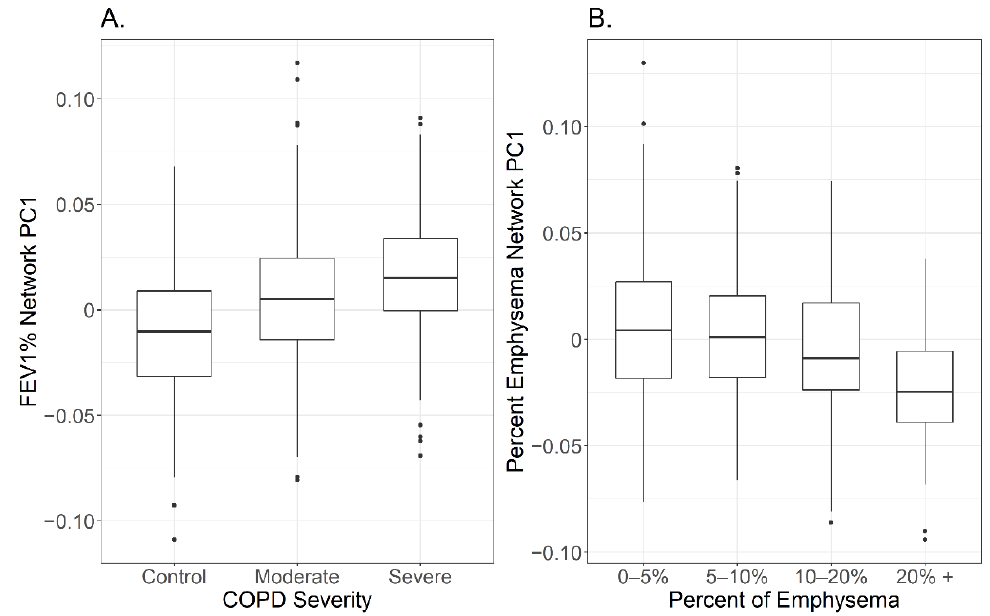
Figure 3. Trends of network first principal component (PC1) with disease severity. Trends within the network associated with FEV 1 % were analyzed by dividing subjects into control, moderate COPD (Gold = 1 or 2), and severe COPD (GOLD = 3 or 4) groups. There were significance di ff erences between all three groups ( p -value < 0.005), with higher PC1 in the severe COPD group versus the moderate COPD group versus the control ( A ). Subjects were also divided by emphysema severity to analyze trends within the network associated with percent emphysema ( B ). Only subjects that had more than 20% emphysema had a significantly di ff erent PC1 than the other three groups ( p -value = 0.00066). Trends within the adjusted network associated with percent emphysema were also